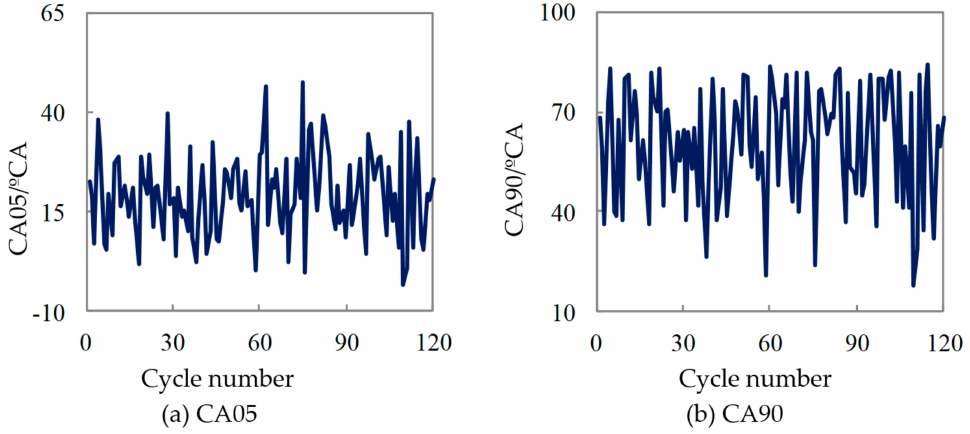
Figure 4. Variation of CA05, CA90 for methanol